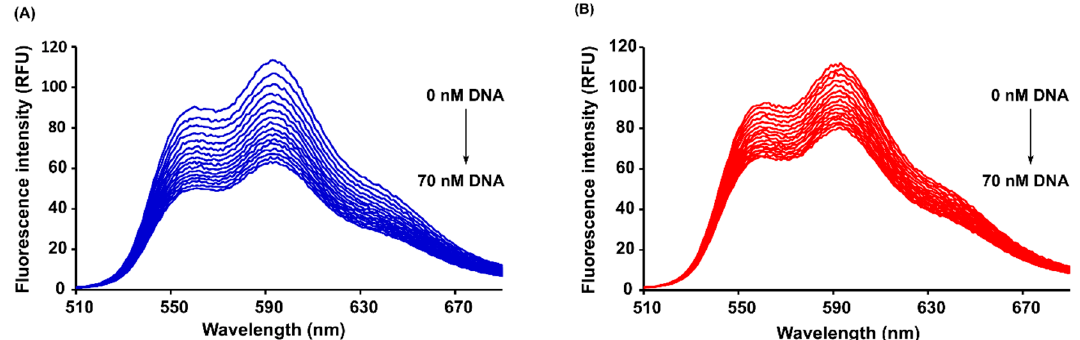
Figure 5. Fluorescence emission spectra of DOX ( A ) and 4-pep–DOX ( B ) in the presence of dsDNA at various concentrations in 10 mM Tris-HCl buffer (pH 7.2) at 25 °C (the initial concentration of DOX and 4-pep–DOX = 1.94 µM).